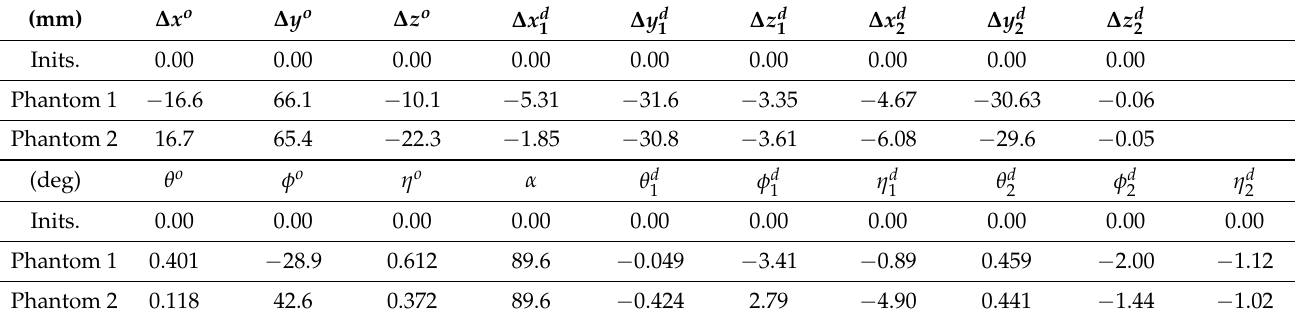
Table 2. Calibrated geometry parameters of the 3D 2 YMOX system with two identical calibration phantoms. (mm) Inits.